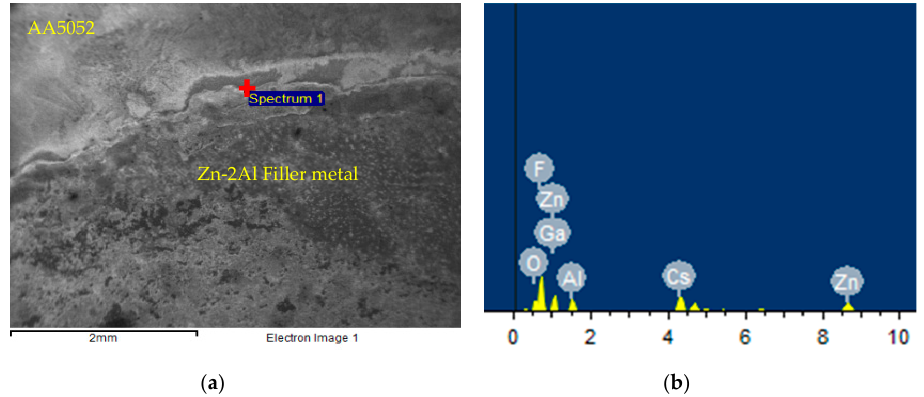
Figure 6. The interface of AA5052 and Zn-2Al filler metal: ( a ) SEM scanning image; ( b ) EDX results of the section.